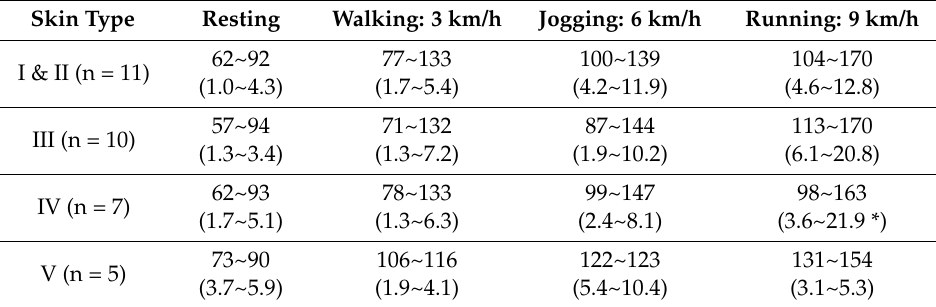
Table 3. Ranges of Average value and standard deviation of human skin types across activities.